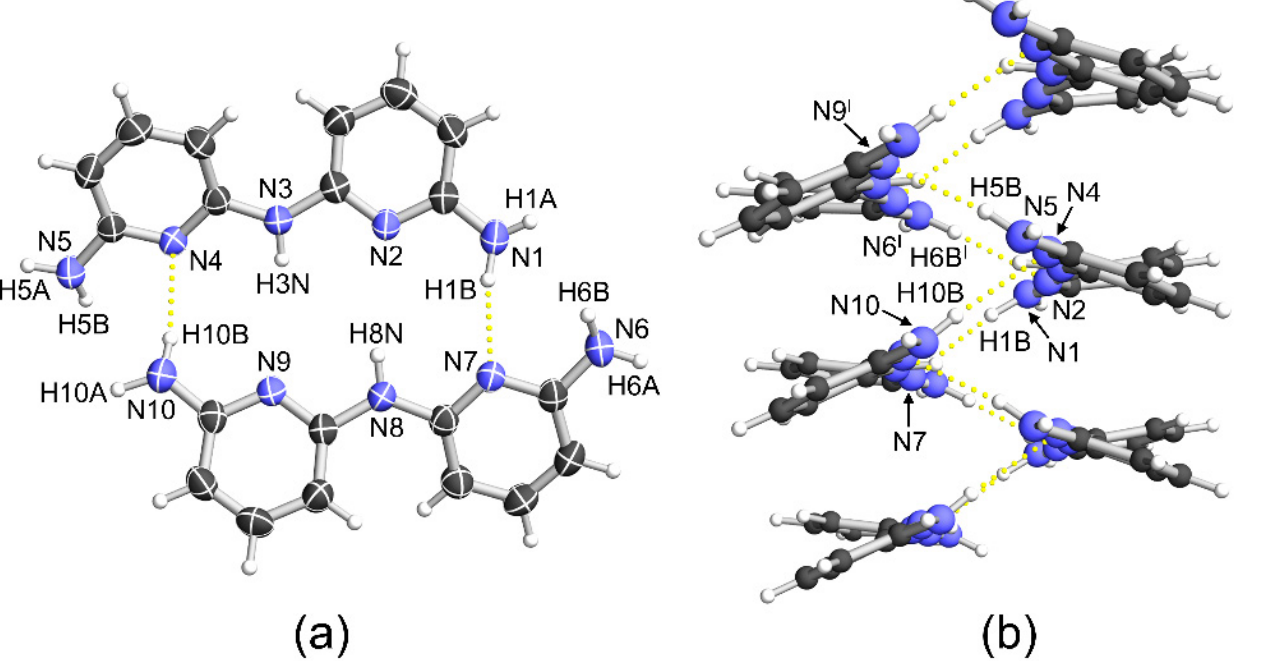
Figure 2. Crystal structure of β -H 5 A, viewed approximately perpendicular ( a ) and parallel ( b ) to the average plane through the asymmetric unit. Color code: C (dark gray), N (blue), and H (white). Thermal ellipsoids in ( a ) are at 60% probability level, while H atoms in ( a ) and all atoms in ( b ) are drawn as spheres of arbitrary radius. Yellow dotted lines indicate hydrogen bonds. Selected interatomic distances and angles: H1B ⋅⋅⋅ N7 = 2.24(4) Å, N1-H1B ⋅⋅⋅ N7 = 168(2)°; H10B ⋅⋅⋅ N4 = 2.25(4) Å, N10-H10B ⋅⋅⋅ N4 = 170(3)°; H5B ⋅⋅⋅ N9 I = 2.20(4) Å, N5-H5B ⋅⋅⋅ N9 I = 166(3)°; H6B I ⋅⋅⋅ N2 = 2.29(4) Å, N6 I -H6B I ⋅⋅⋅ N2 = 168(3)°. Symmetry code: I = x , y + 1, z .